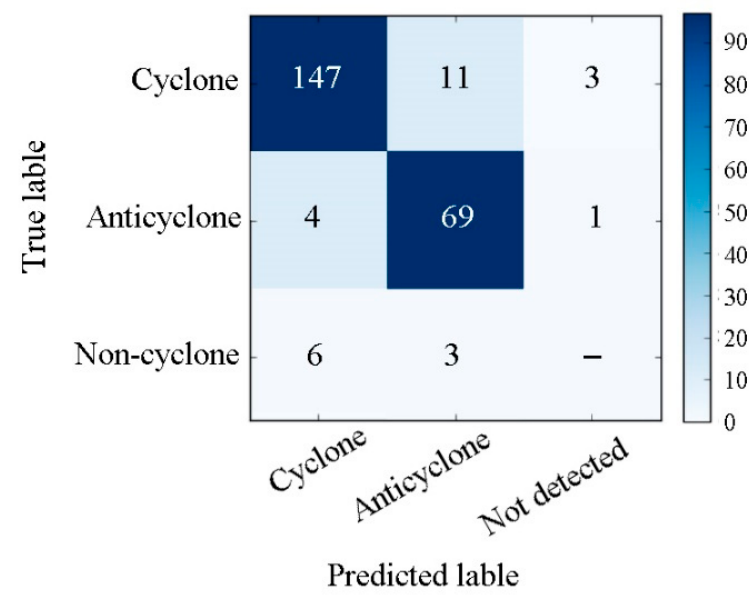
Figure 3. Detection result on 25 February 2020 on globe scale. The spatial resolution of the velocity vectors in the insert panel is at 0.25° × 0.25°, while that of the global vectors is sampled down to 4° × 4°.